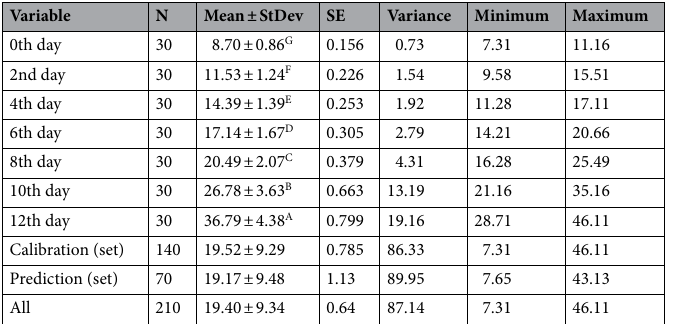
Table 1. Descriptive statistics for TVB-N content of samples, measured by the conventional methods. Different letters indicate significant difference between average of samples ( p <